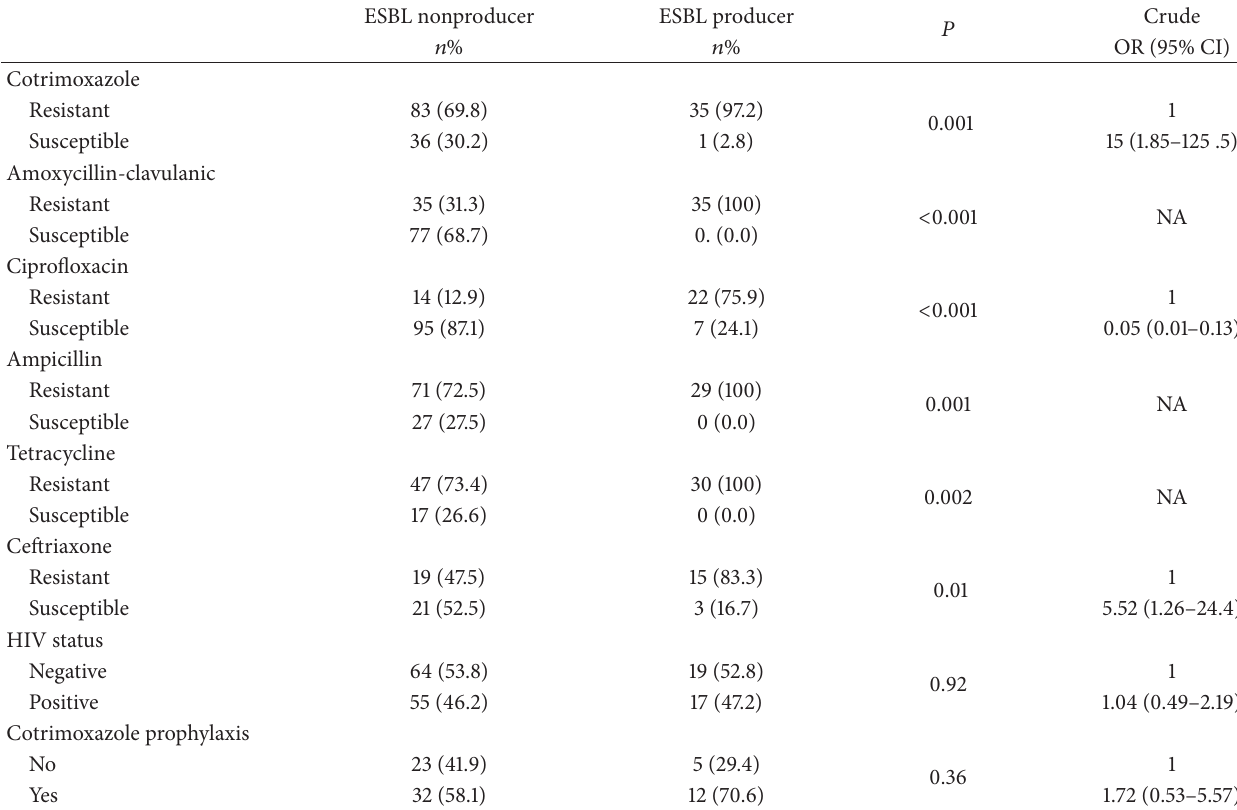
Table 5: Predictors of ESBL producing isolates among 155 clinical